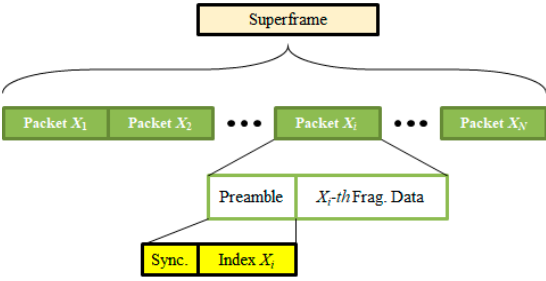
Figure 1. Superframe structure for transmitting streaming data.